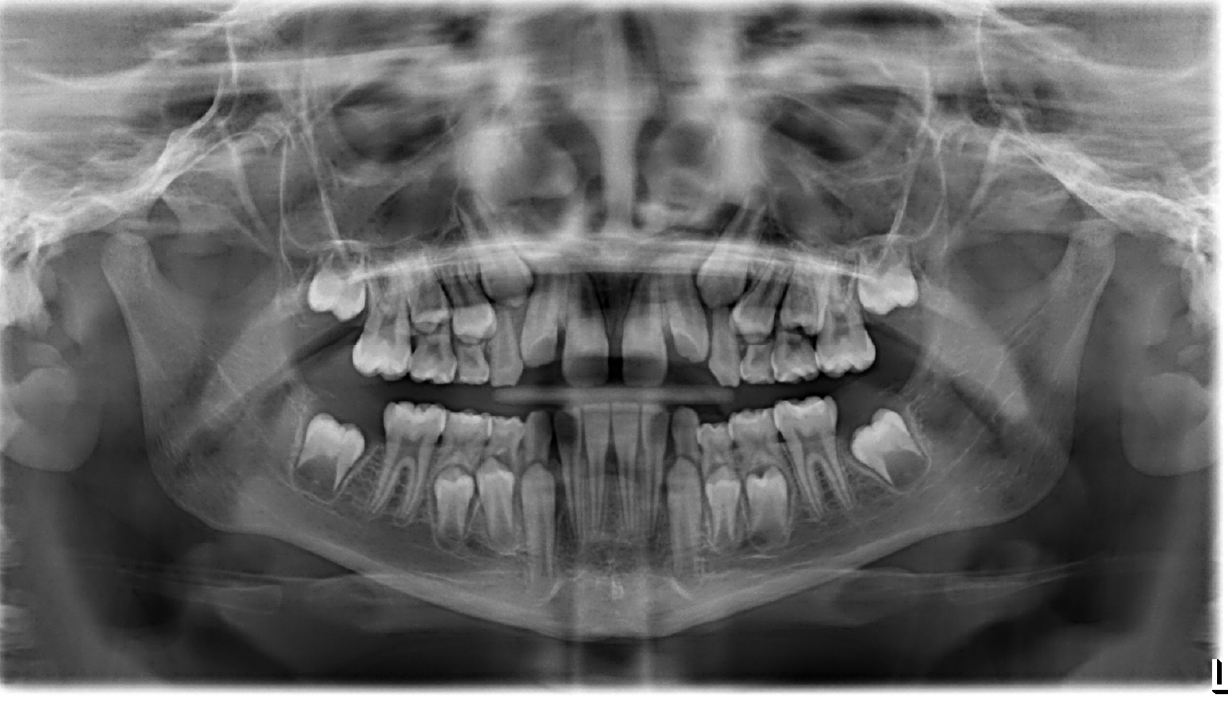
Figure 20. Cephalometric tracing (DeltaDent software) after treatment shows a skeletal class I (8- year-old). Table 4. Cephalometric analysis after treatment.